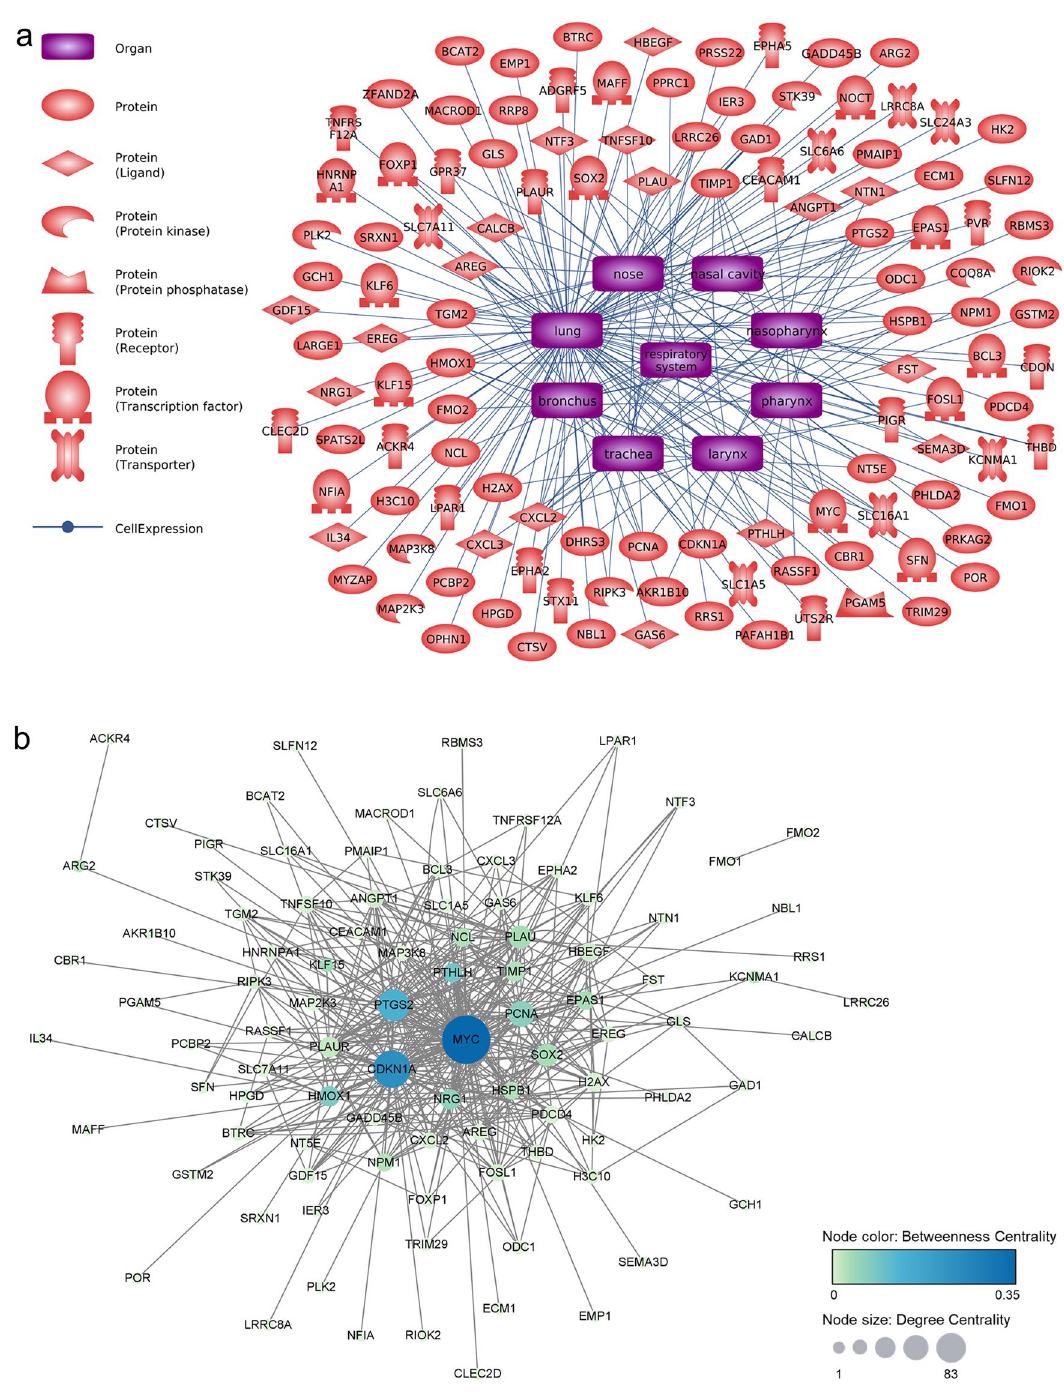
Figure 4. Biological networks for respiratory effects of formaldehyde exposure. ( a ) Genes with respiratory system expression information. Among the common DEGs, only genes with expression information in major respiratory organs were selected using Pathway Studio (version 12.3). ( b ) Gene–gene interaction network. Topological parameters among the genes were calculated using Cytoscape (version 3.7.2). ( c ) Formaldehyde- related major cell processes and respiratory diseases. ( d ) Respiratory system-related biological network associated with formaldehyde exposure. The biological network was constructed based on the results of the previous network analysis. Red and blue highlights, respectively, indicate up- and downregulated